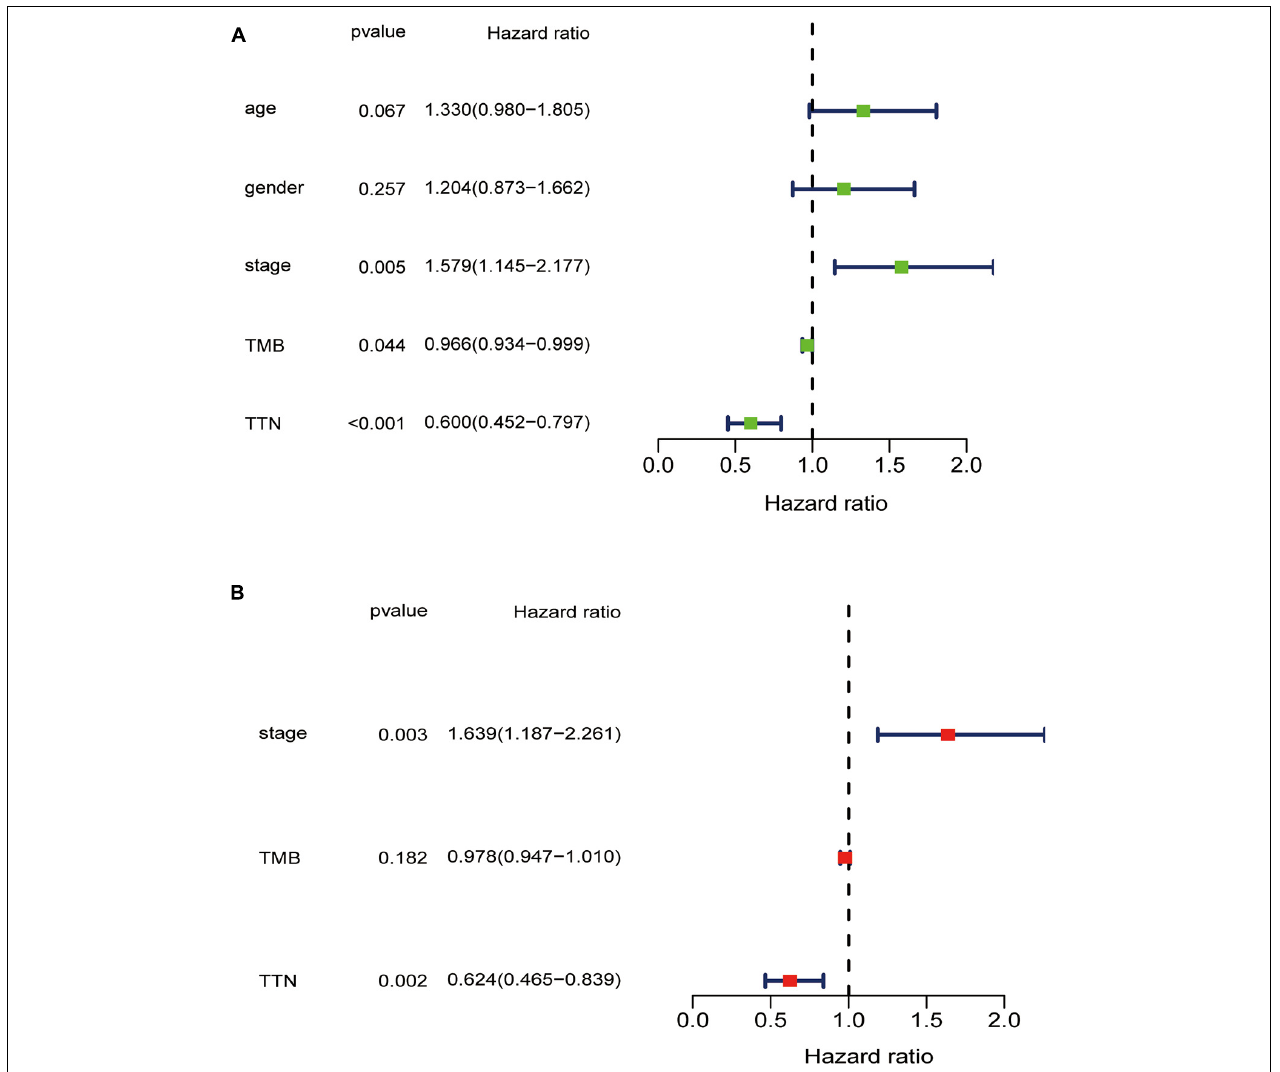
FIGURE 4 | Univariate (A) and multivariate (B) overall survival analysis of lung squamous cell carcinoma patients via the Cox proportional hazards